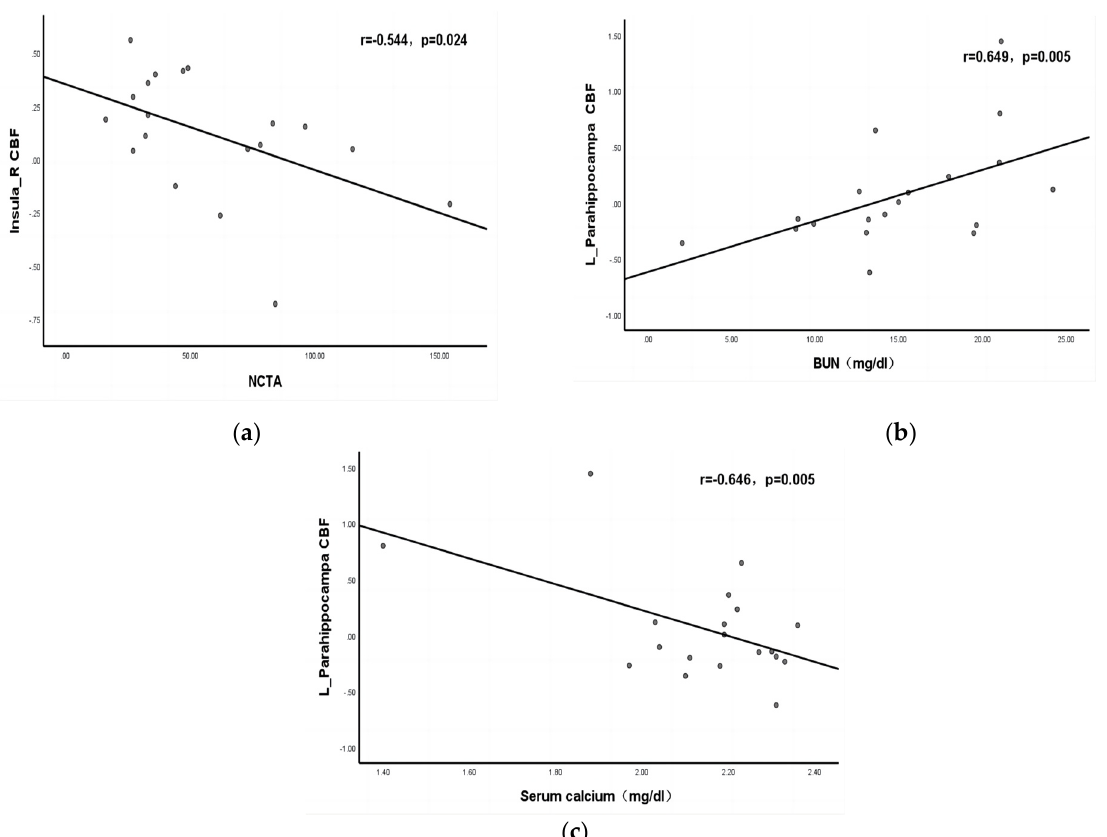
Figure 3. Correlation of clinical biochemical indicators and neuropsychological scores with CBF among subgroups ( a ). Partial correlation analysis found that CBF in the right insula was negatively correlated with NCT-A scores (r = –0.544, p = 0.024); ( b ) CBF in the left hippocampus was positively correlated with BUN (r = 0.649, p = 0.005); ( c ) CBF in the left hippocampus was negatively correlated with serum calcium (r = –0.646, p = 0.005).